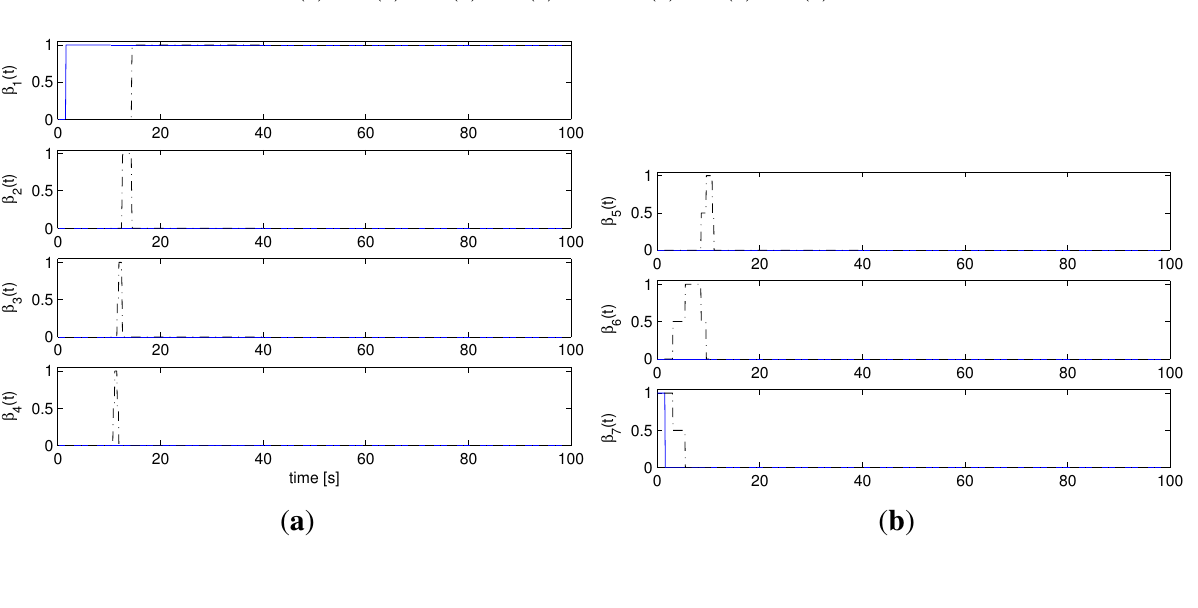
Figure 6. Ideal case, θ ∗ = 0 . 05 : AMC controller weights β ( t ) : Multi-AMC (solid), AMC (dash-dotted). ( a ) β